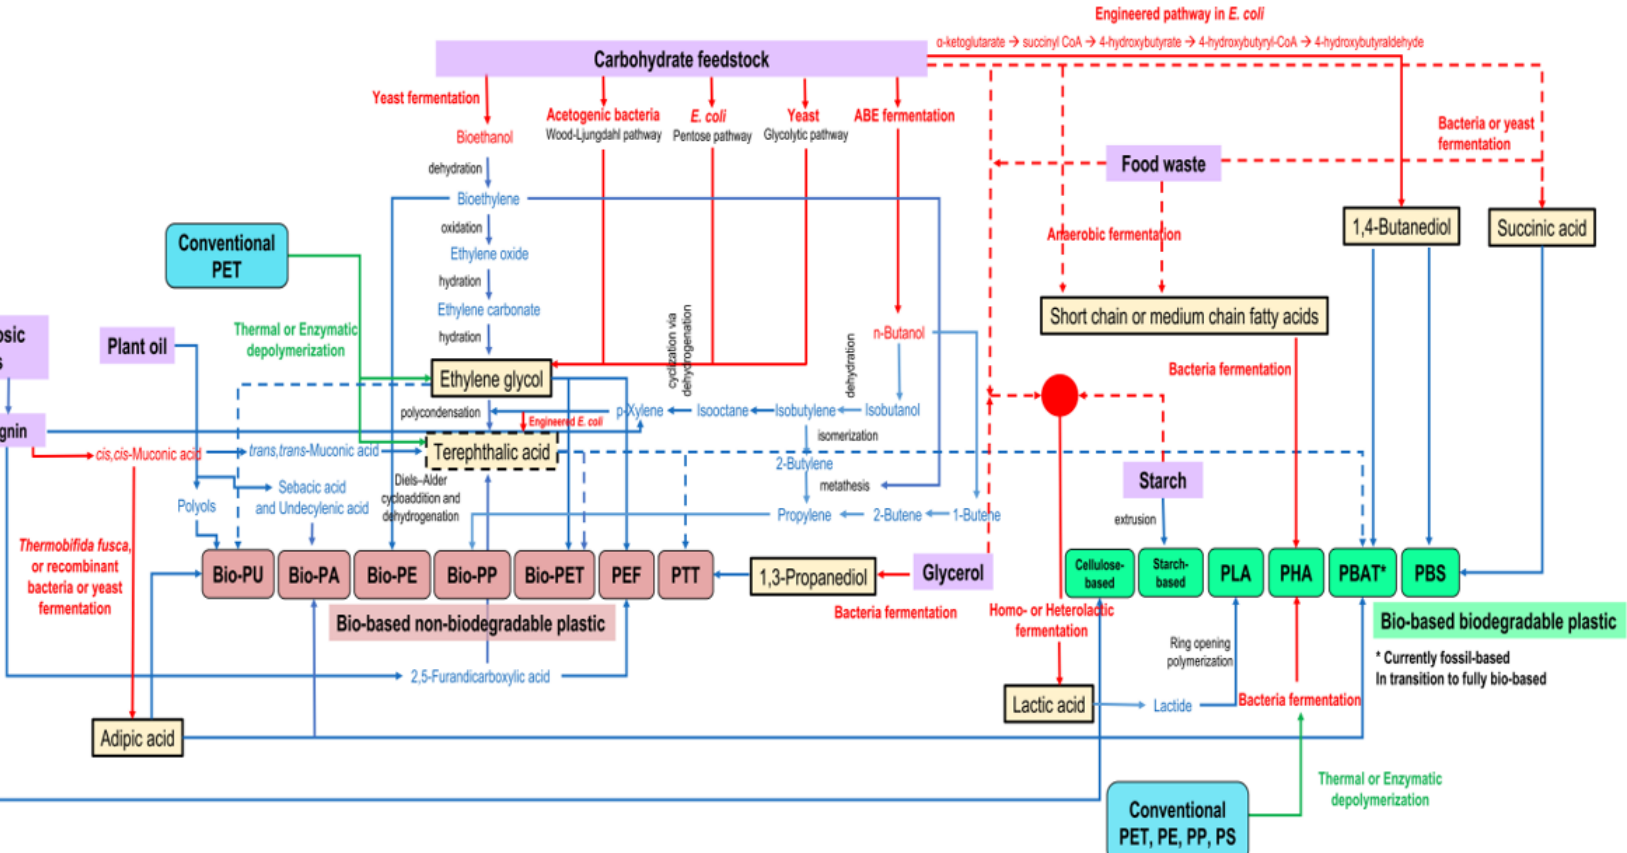
Figure 5. Overview of the production of renewable plastics from bio-based and upcycled building blocks. The blue lines show chemical conversion, while the red lines show biological conversion/fermentation processes. The green lines show integration of conventional plastic upcycling to bioplastic production. Solid and dashed lines are used to better distinguish the different pathways.